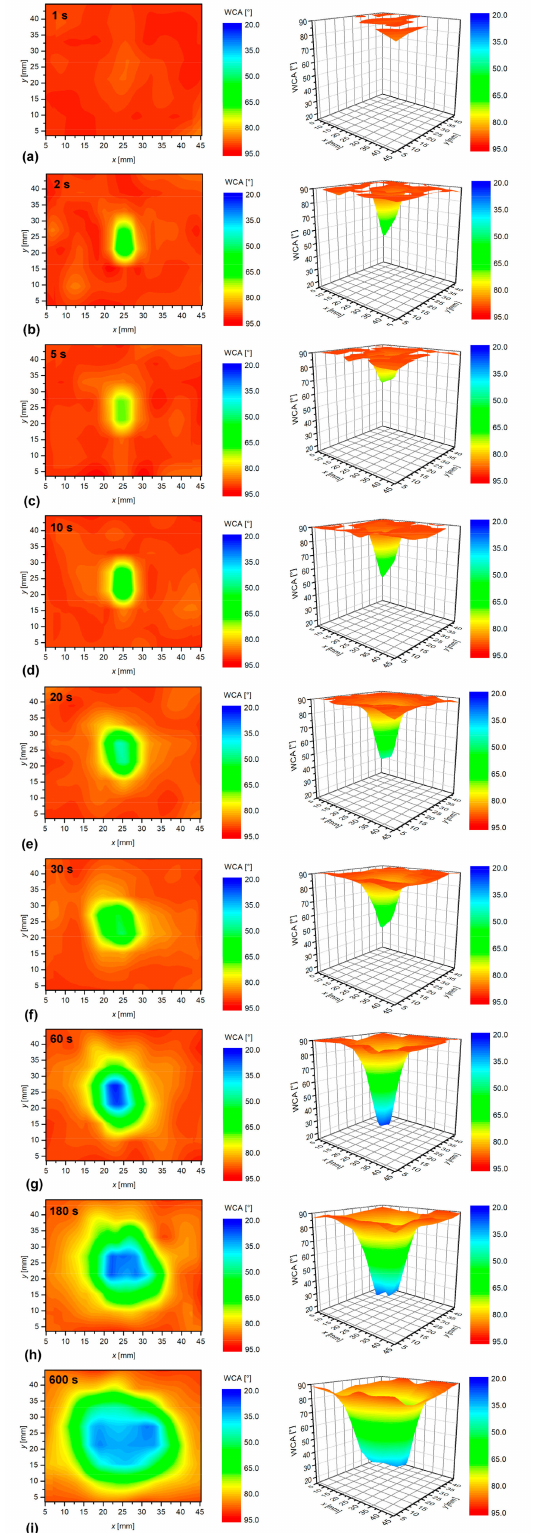
Figure 10. Evolution of the surface wettability for polystyrene treated at various treatment times for the sample distances of 30 mm from the APPJ nozzle: ( a ) 1 s, ( b ) 2 s, ( c ) 5 s, ( d ) 10 s, ( e ) 20 s, ( f ) 30 s, ( g ) 60 s, ( h ) 180 s, ( i ) 600